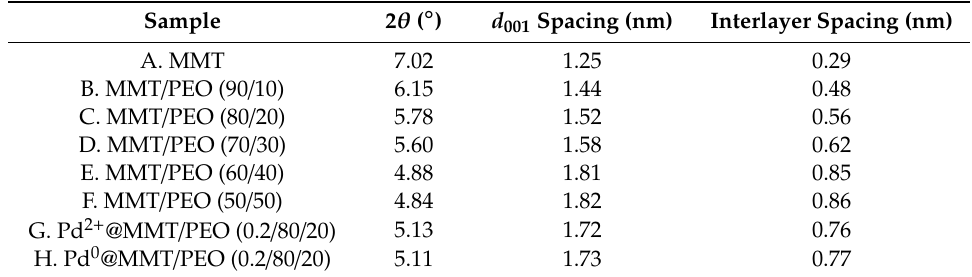
Table 1. Results of d 001 spacing and corresponding interlayer spacing (subtracting the thickness of MMT layer of 0.96 nm) of the investigated MMT from XRD.